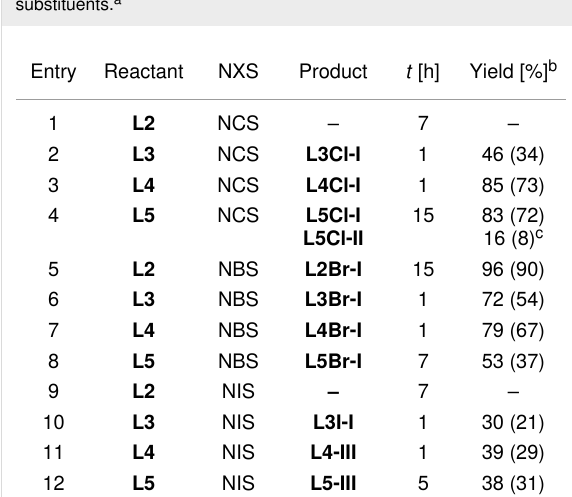
Table 1: Halogenation of azobenzenes with strong electron-donating substituents.